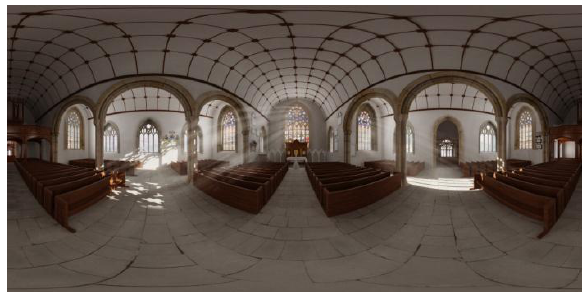
Figure 6 Reconstruction of the church presented from the same location as the panorama in Figure 5.